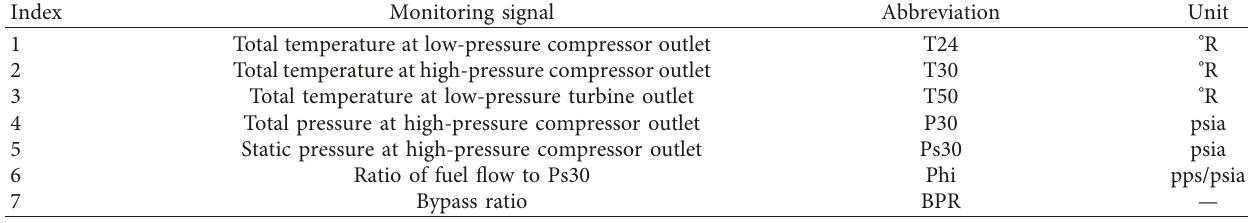
Table 2: Description of the selected monitoring signals for the construction of IDI series.